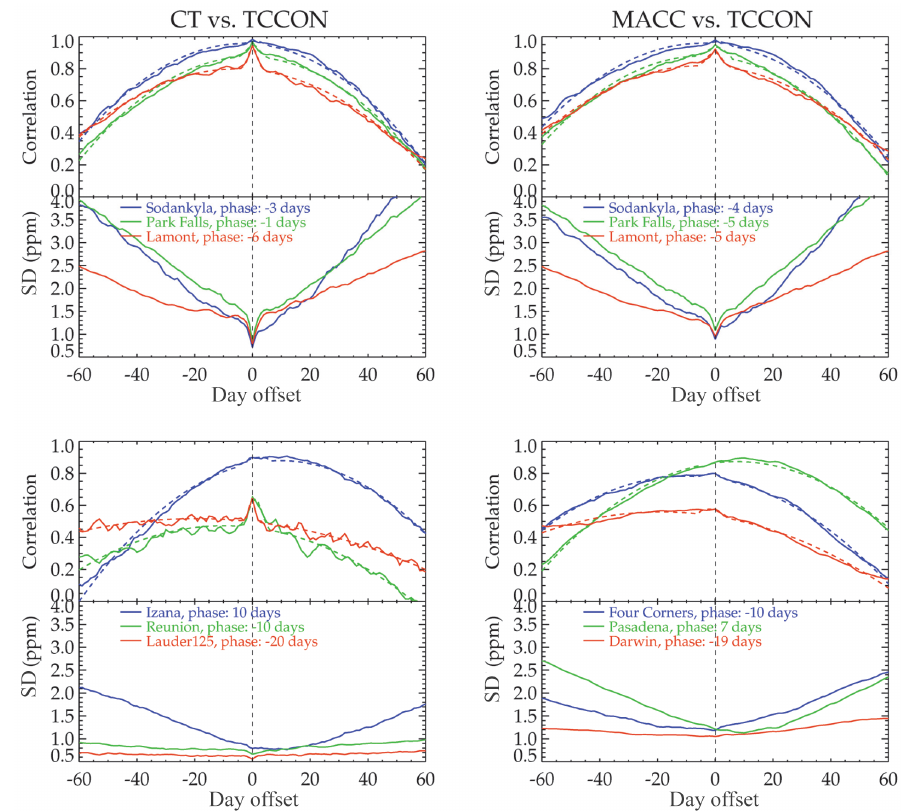
Figure 11. Top: cross correlation examples between TCCON and CT2013 (left) or MACC (right). Each panel shows the correlation and second-order polynomial fits (top) and standard deviation (bottom) vs. offset in days of TCCON vs. satellite data. The correlation should be at a maximum and standard deviation at a minimum at days offset = 0. The top panels show examples of stations with a phase difference of less than 10 days. The bottom set shows example stations which have phase differences of at least 10